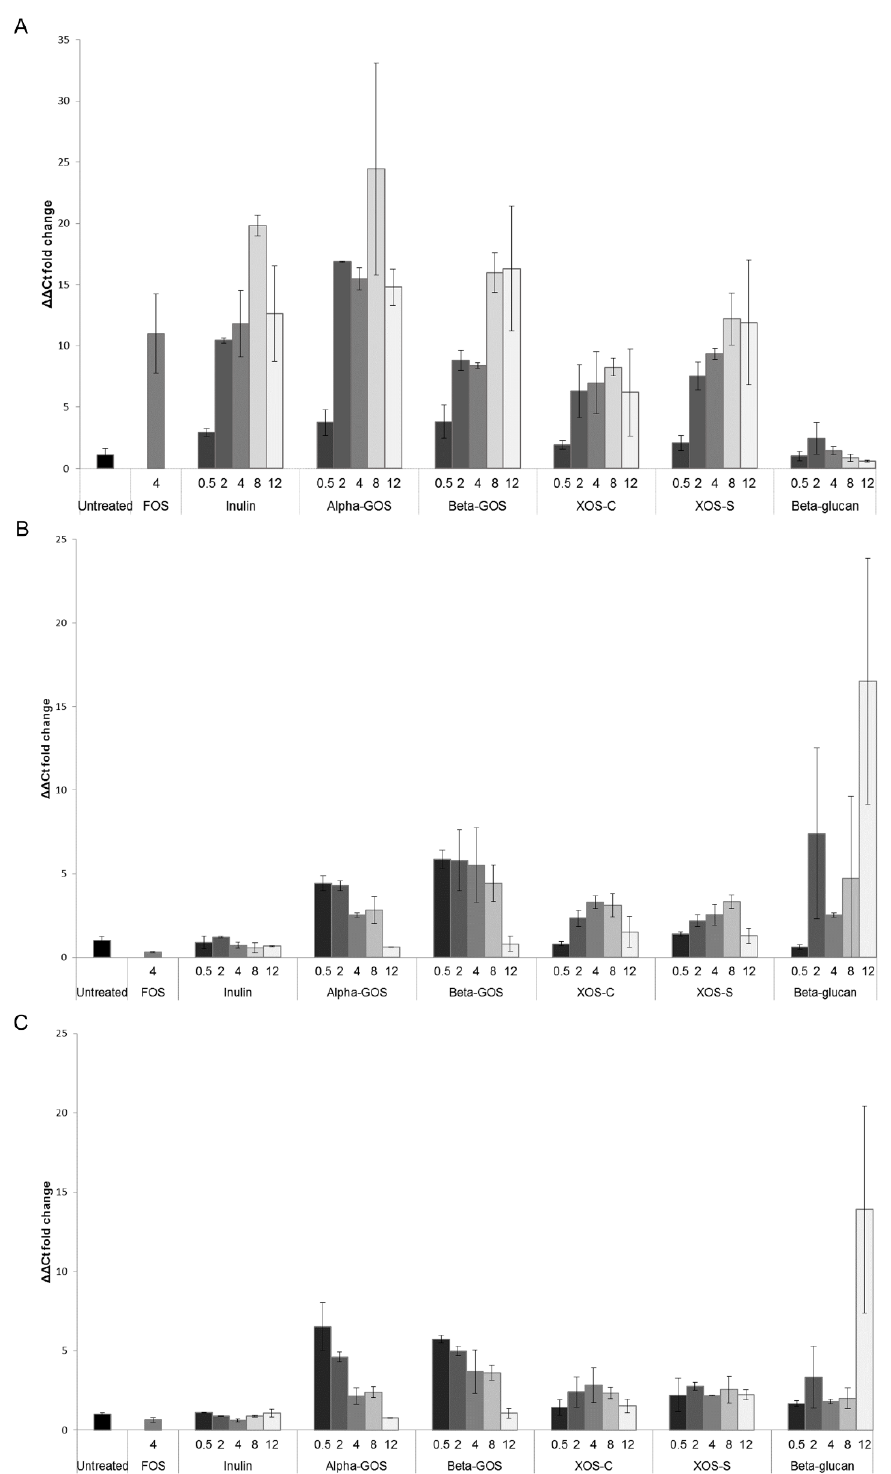
Figure 1. Mean relative fold change of bacterial groups in 24 h fermentation samples, as measured by qPCR. Values are expressed as the mean ± standard deviation, obtained from the average of duplicate (inulin, alpha-linked galacto-oligosaccharides (alpha-GOS), beta-linked galacto-oligosaccharides (beta-GOS), xylo-oligosaccharides from corn cobs (XOS-C), xylo-oligosaccharides from high-fiber sugar cane (XOS-S), and beta-glucan) or triplicate (control and fructo-oligosaccharides (FOS)) samples. ( A ) Bifidobacterium , ( B ) Lactobacillus group 1, and ( C ) Lactobacillus group 2.